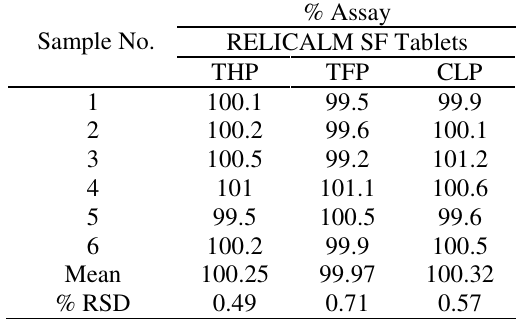
Table 7. Assay of THP, TFP and CLP in their combined tablet